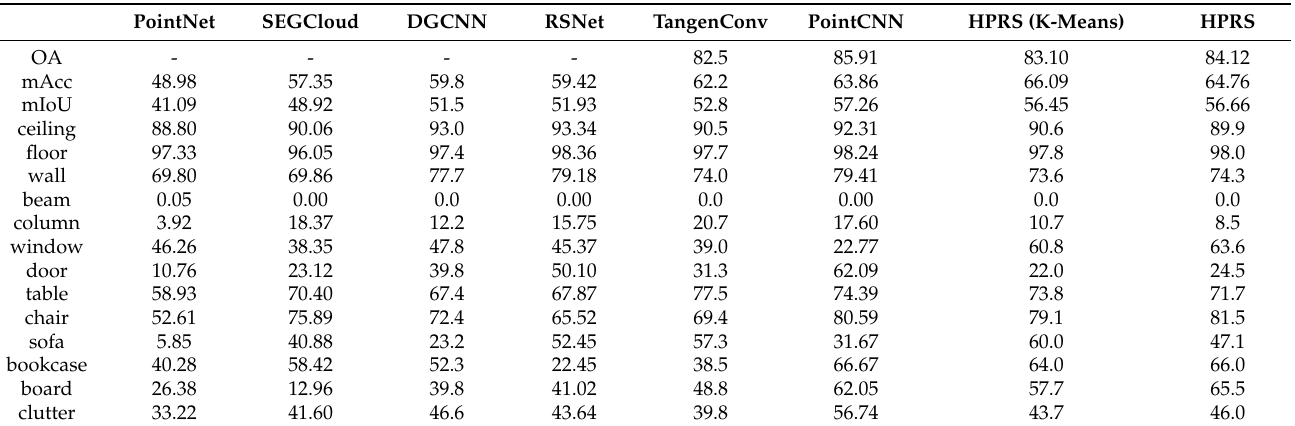
Table 5. Quantitative results of different approaches for the Area 5